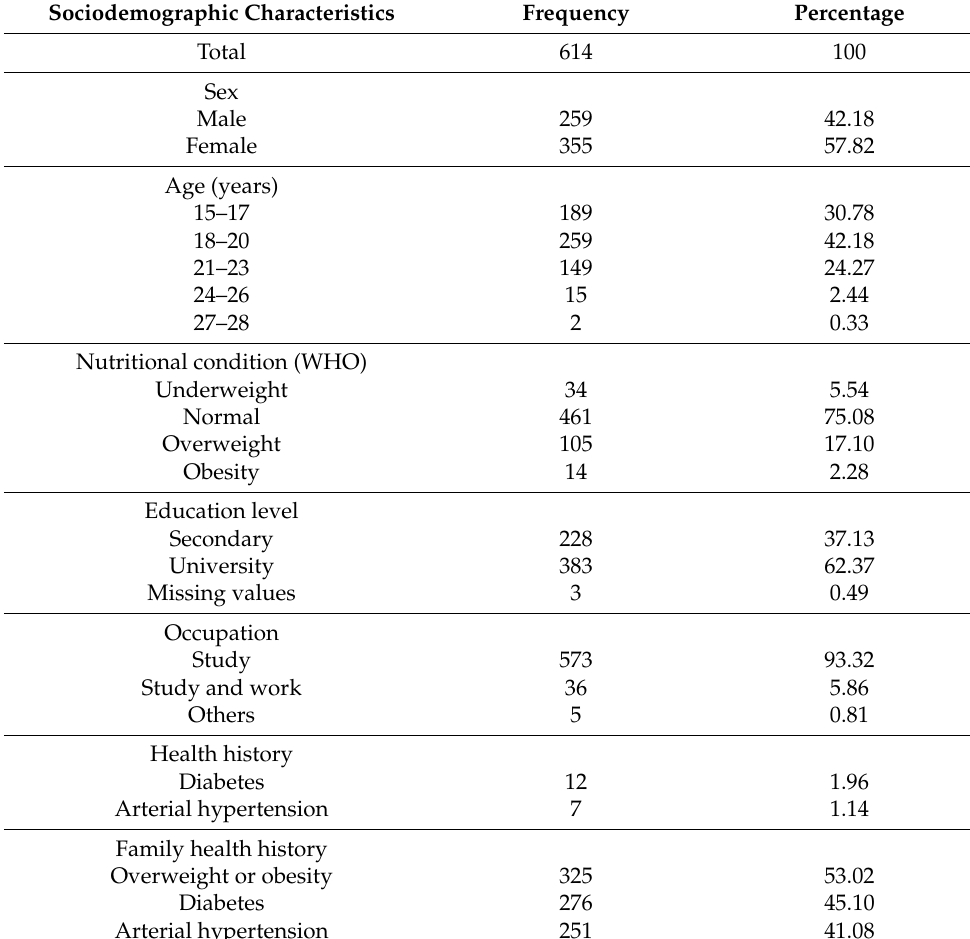
Table 1. Sociodemographic